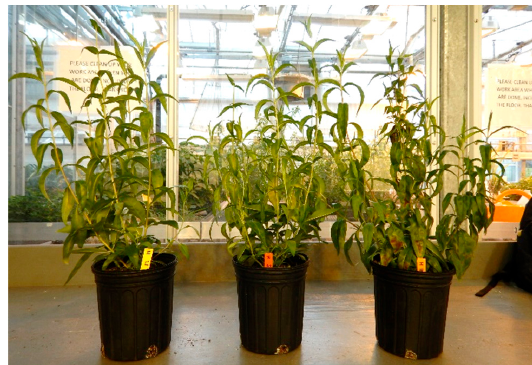
Figure 1. Representative ‘Ruby Candle’ beardtongue plants maintained at 18% VWC at the conclusion of the 73 day experiment. Plants received 25% (3 g / plant), 50% (6 / plant), or 100% (12 g / plant) of the medium bag rate of controlled release fertilizer (left to right).